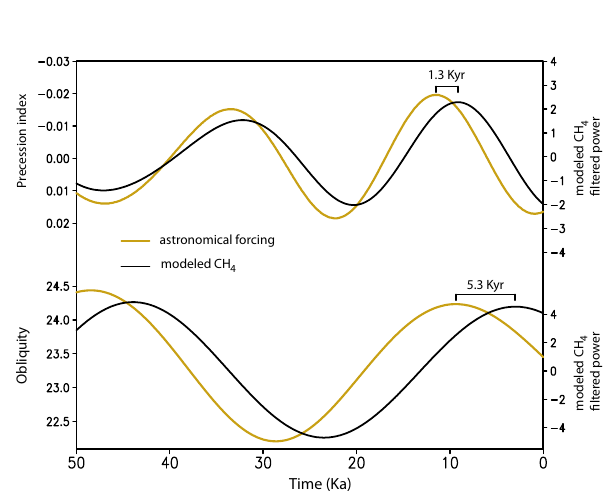
Fig. 7. Definition of the tropical (red), boreal (blue) and In- dian/Asian monsoon (pink) zones. Emissions from these three zones are separately analyzed.